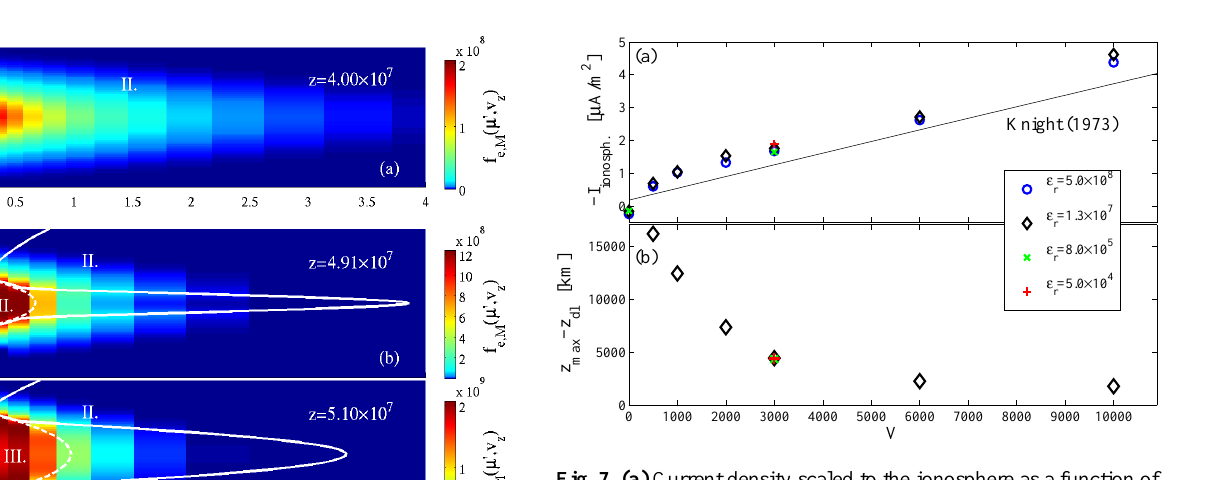
Fig. 7. (a) Current density scaled to the ionosphere as a function of the voltage across the system. The different symbols correspond to runs with different values of (cid:15) r . At the two highest (cid:15) r values, 4 . 98 × 10 8 and 1 . 27 × 10 7 , simulations have been run for all voltages. At (cid:15) r = 1 . 27 × 10 7 , simulations have been run for 0 and 3kV, and at the lowest value, (cid:15) r = 4 . 98 × 10 4 , the simulation has been run only for a total voltage of 3kV. The black line shows Knight’s current– voltage relationship. (b) Double layer position as a function of the total acceleration